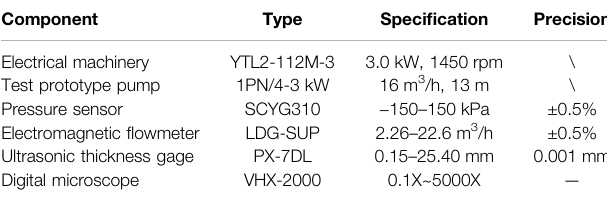
TABLE 1 | Main component parameters of the experimental system.